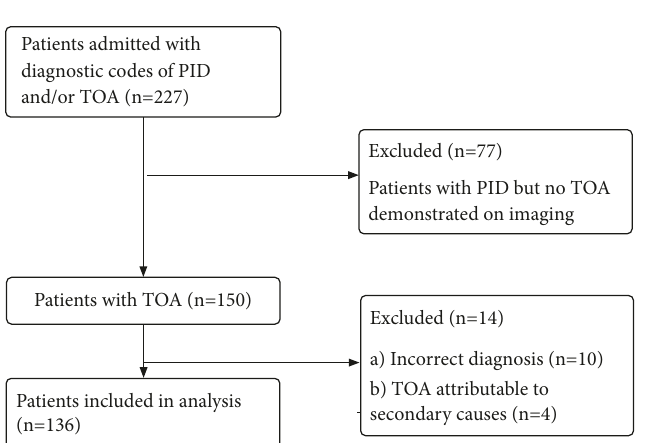
Figure 1: Flowchart of patients included in this